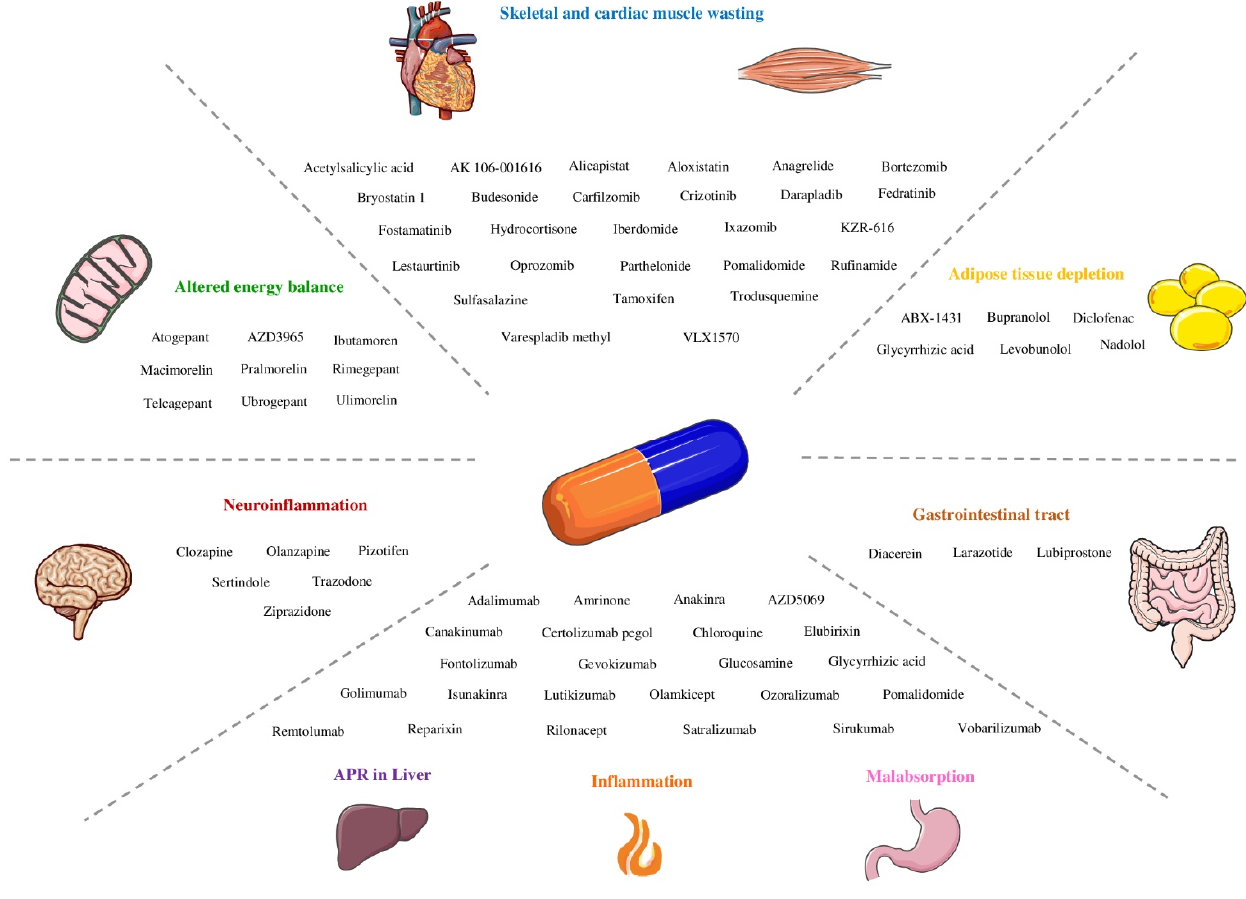
Figure 2. Drugs present in cachexia’s phenotypes.